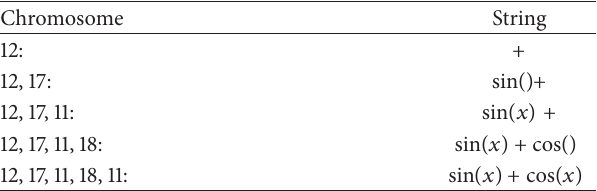
Table 2: Construction of the function 𝑓(𝑥) = sin 𝑥 + cos 𝑥 .